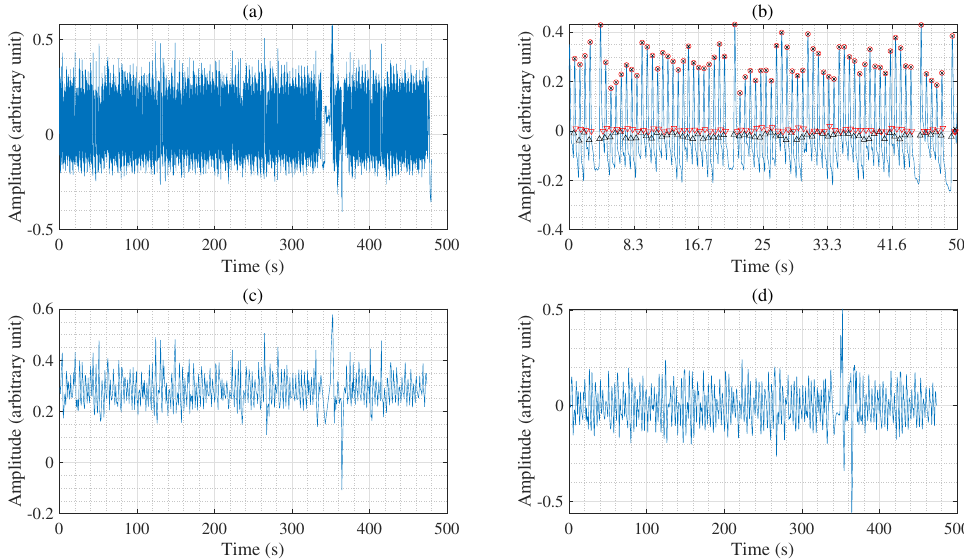
Figure 2. An example of preprocessing, where ( a ) denotes a PPG signal after removing a high- frequency (HF) signal; ( b ) denotes a partial PPG signal of 50 s shows maximum points in the ppg signal of about 480 s; ( c ) is maximum points in the ppg signal (480 s); ( d ) denotes a resample PPG